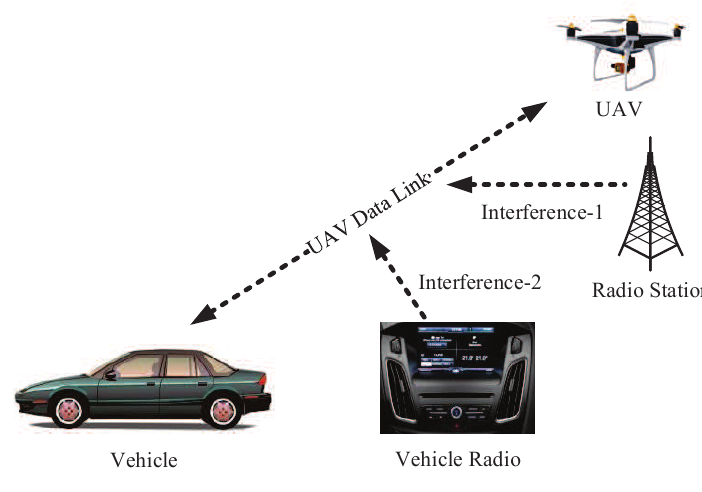
Figure 9. SFCW interference.